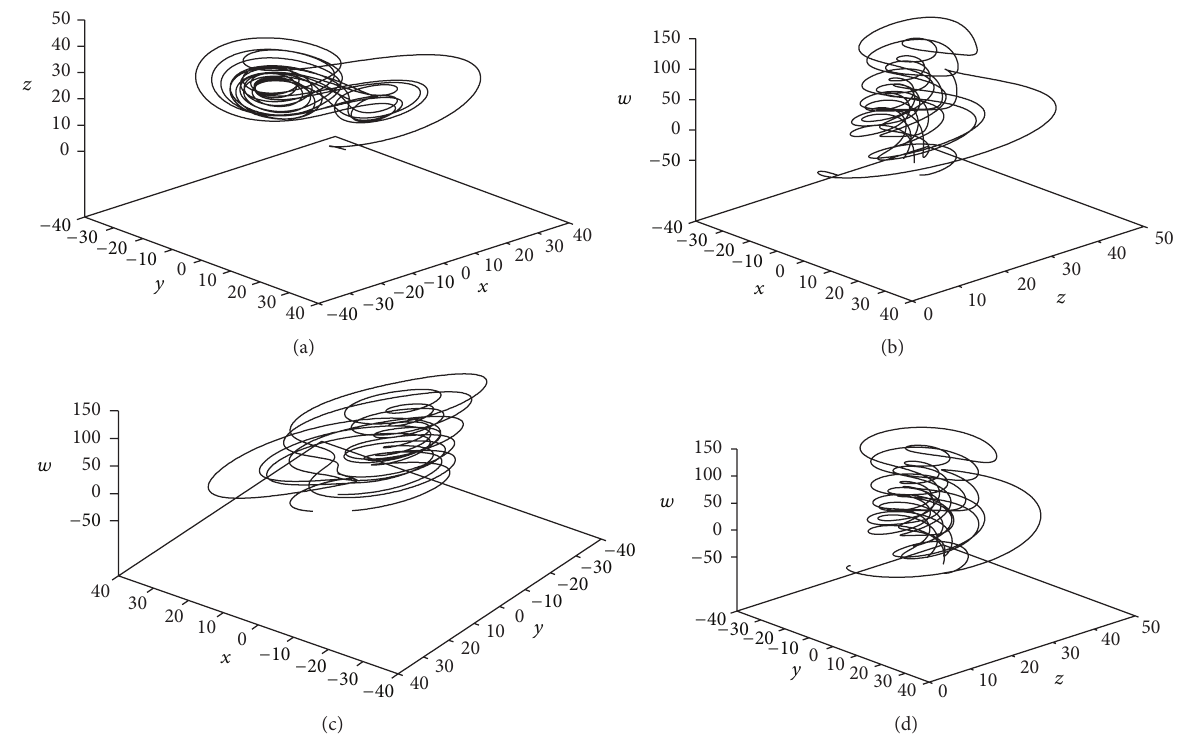
Figure 8: Phase portraits using 15-term MHPM on Δ𝑡 = 0.001 of Case 3 hyperchaotic L¨u